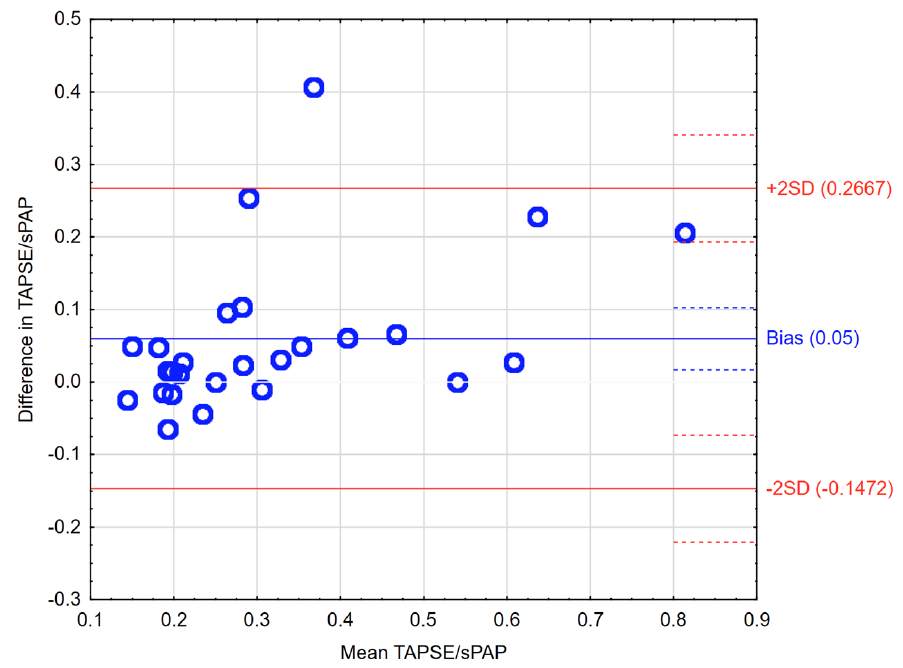
Figure 1. Bland–Altman plot presenting differences between echo-derived TAPSE/sPAP and non- echo-derived TAPSE (MRI)/sPAP (RHC) ratios.